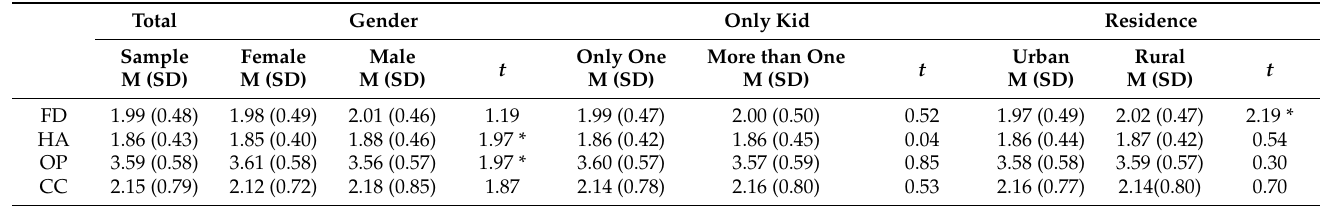
Table 1. Means, standard deviations, and t -tests of main variables.